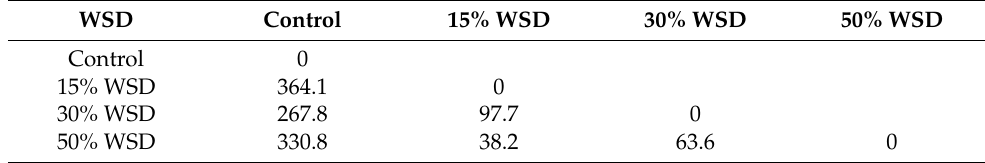
Table 1. The Mahalanobis distances between water saturation deficit (WSD) levels based on all nine traits.